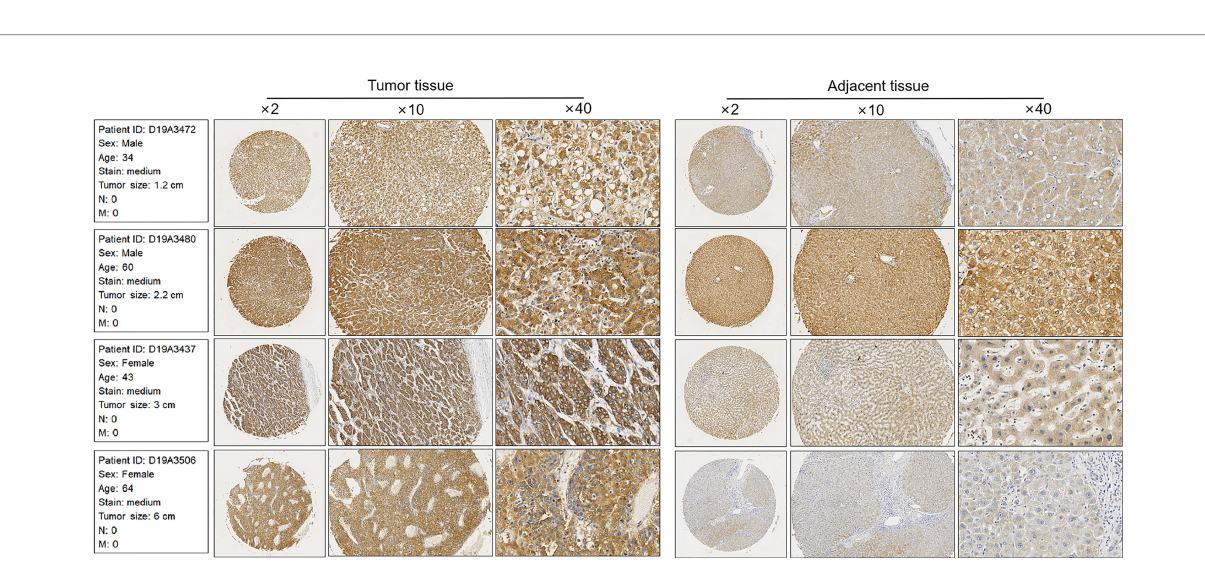
FIGURE 3 | Immunohistochemical staining of CCDC88A in serious LIHC and non-tumor adjacent tissues. Four pairs of LIHC tissues were Immunohistochemically analyzed. Images were taken under ampli fi cation of 2, 10, and 40,